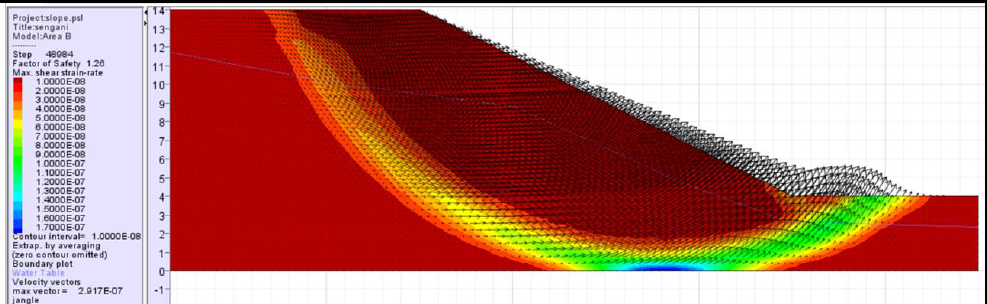
Figure 26. Simulated FoS of the silt clay soil slope using FLACSlope in rainy conditions with a water table with 2500 m 3 volume of water. Note that maximum shear strain simulated ranges between 1.0 × 10 −7 to 2.917 × 10 − 7 .